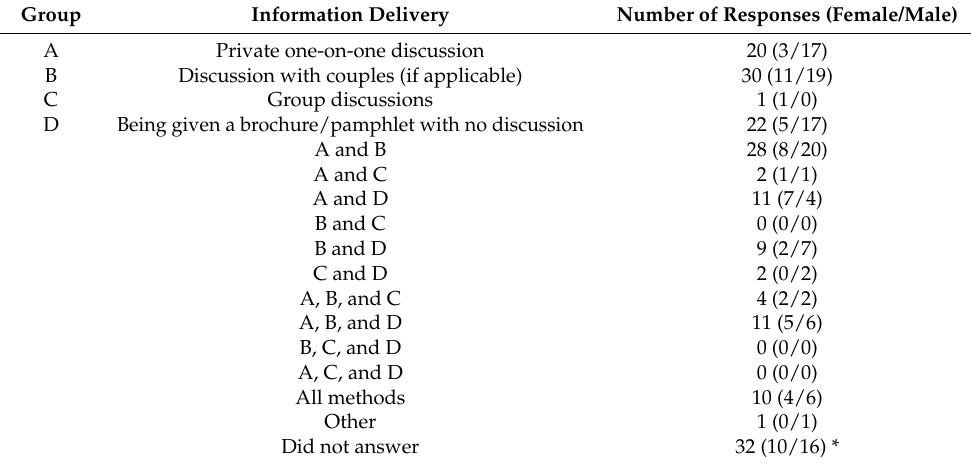
Table 3. Preferred information delivery method.